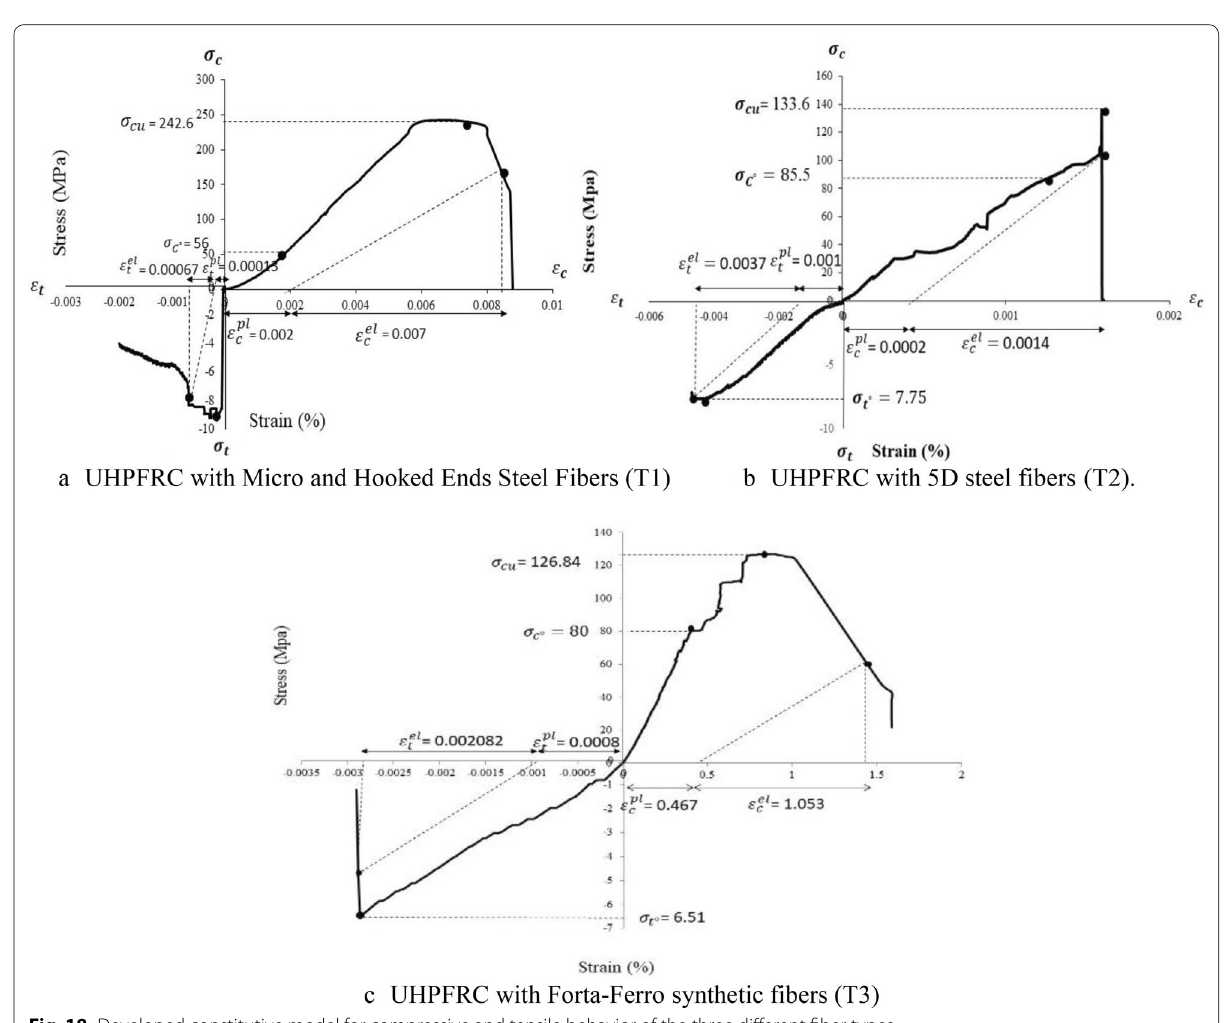
Fig. 18 Developed constitutive model for compressive and tensile behavior of the three different fiber